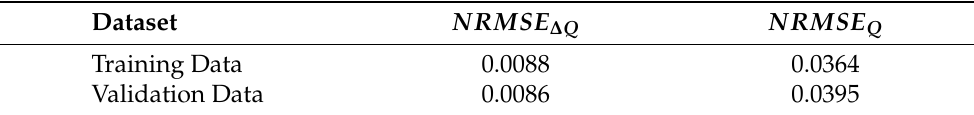
Table 6. Training and validation—no voltage